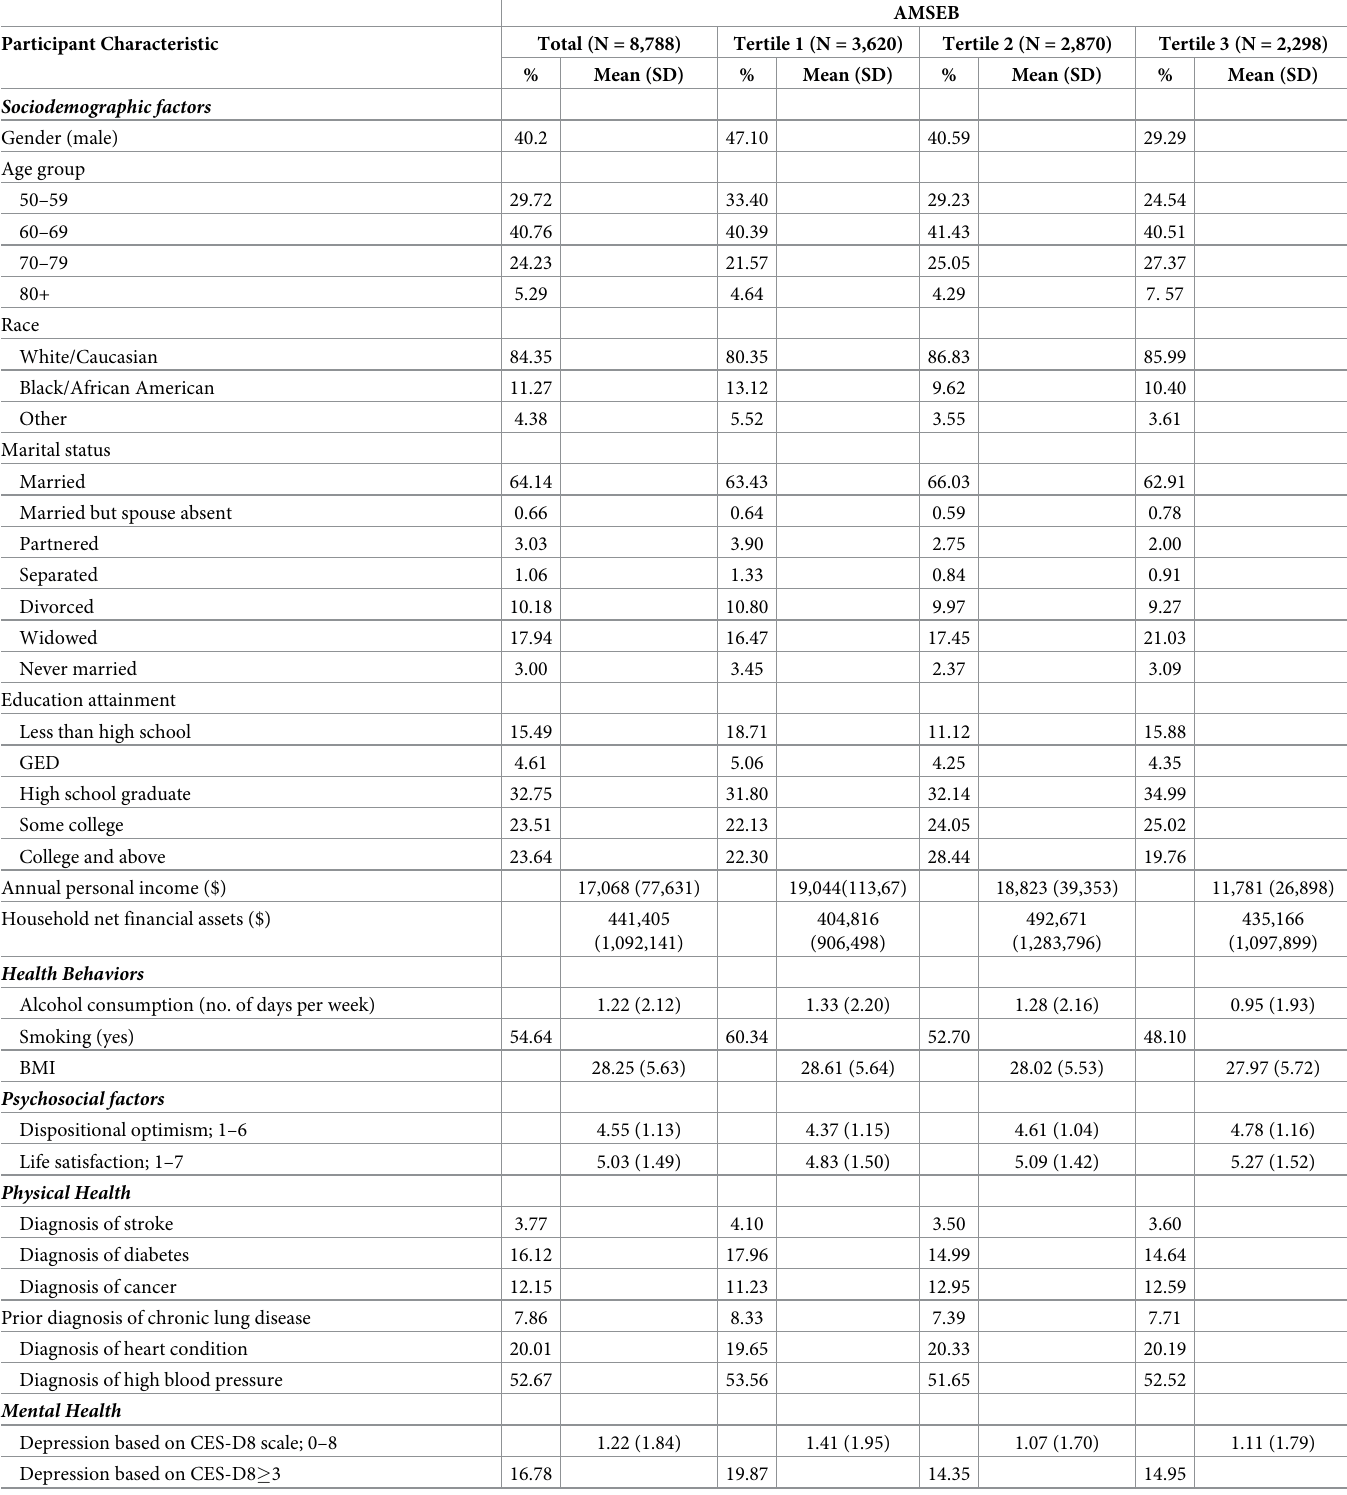
Table 1. Distribution of participant characteristics by adherence to moral standards and ethical behaviors at study baseline, health and retirement study,